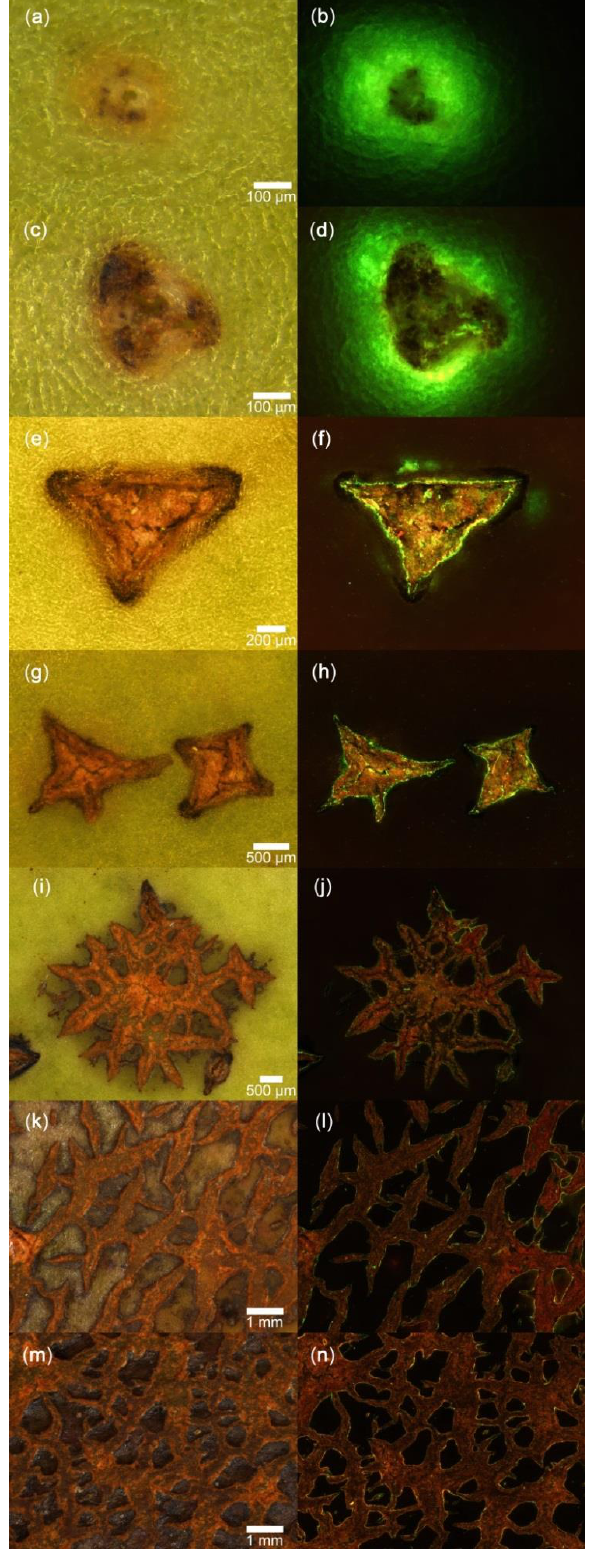
Figure 3. Microscopic view of ‘Apple’ mango skin infiltrated with acridine orange dye when viewed with a binocular microscope under natural ( a , c , e , g , i , k , m ) or fluorescent light ( b , d , f , h , j , l , n ). The scale bars refer to the corresponding pairs of images.